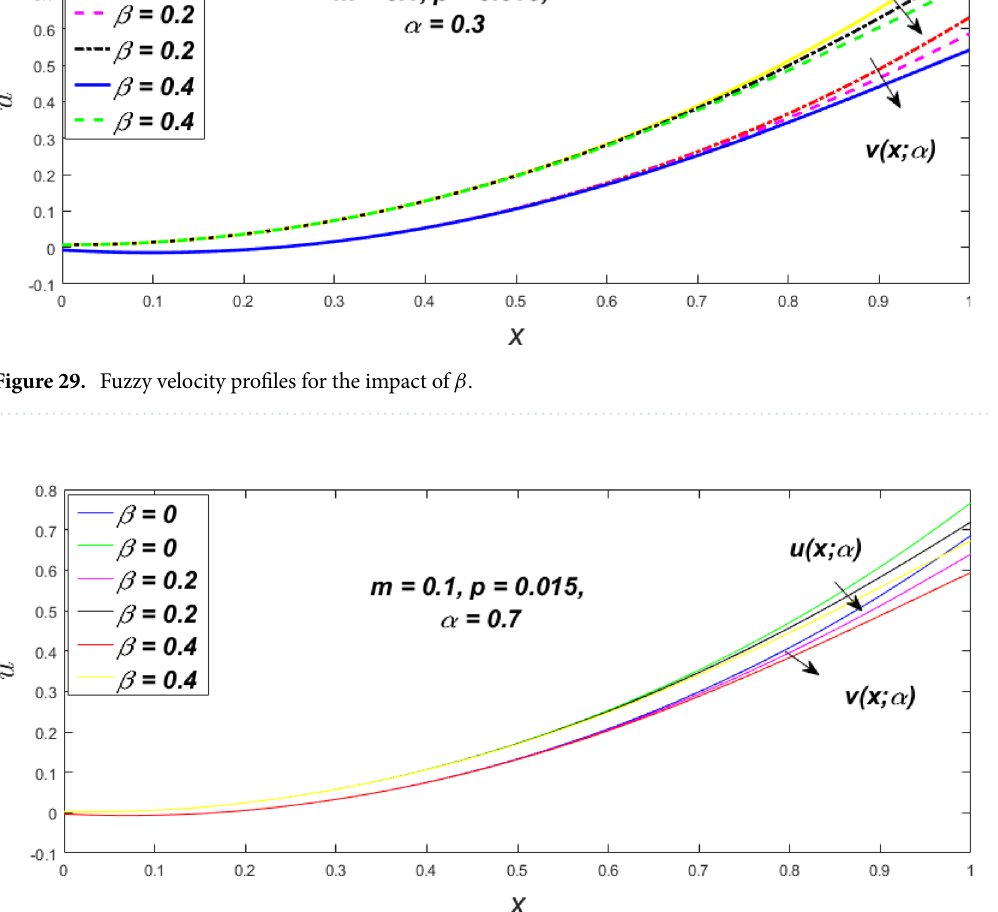
Figure 30. Fuzzy velocity for the impact of β